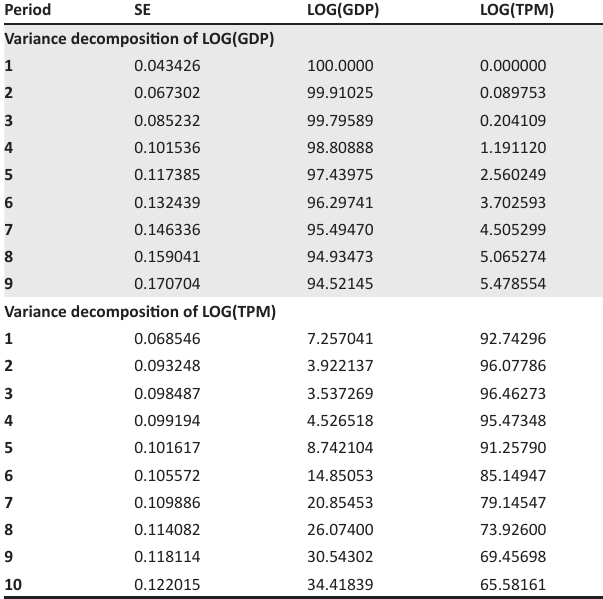
TABLE 2-A1: Variance